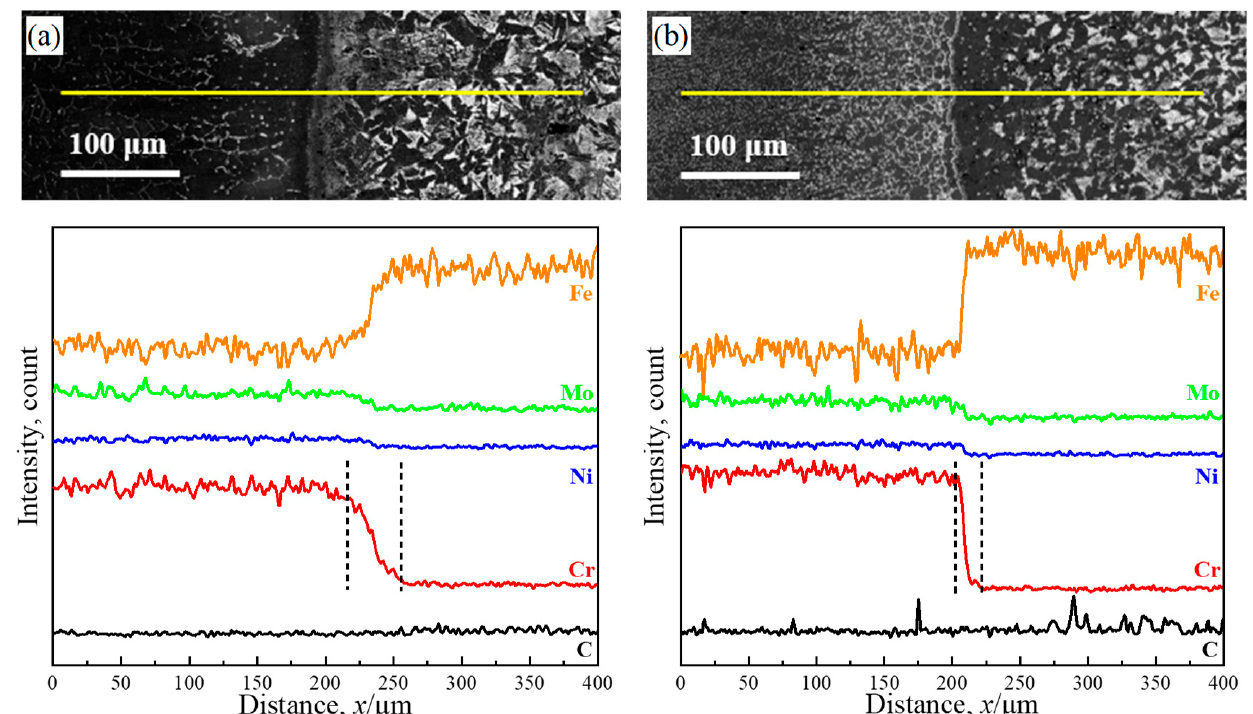
Figure 5. EDS linear scan analysis across the interface: ( a ) as-deposited, ( b ) as-rolled.